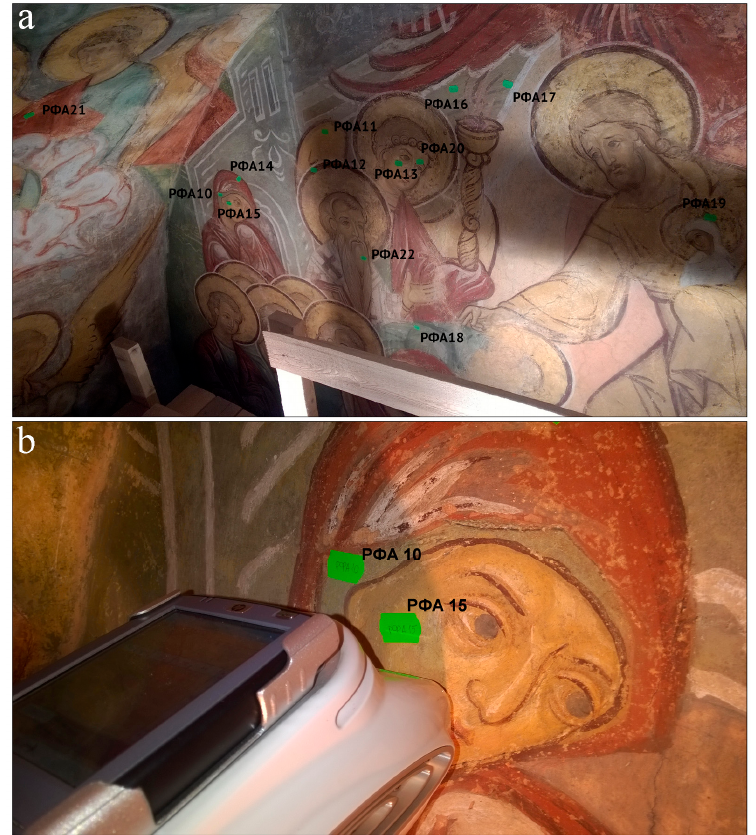
Figure 1. ( a ) The fresco #1, “The Assumption of the Mother of God” with the location of some of the analyzed points; ( b ) Detailed image of the fresco, with the portable X-ray fluorescence (XRF) analyzer.